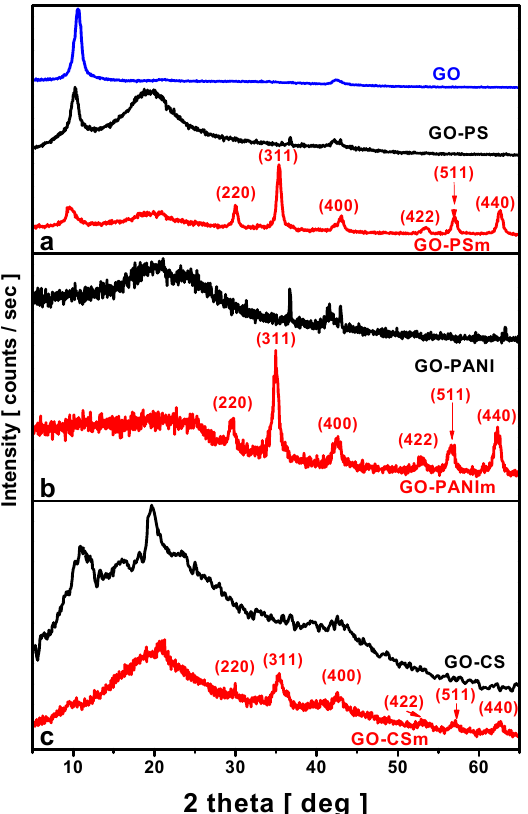
Figure 1. X-ray di ff raction pattern of composed materials from 5 ◦ to 65 ◦ . ( a ) GO-PS and GO-PSm; ( b ) GO-PANI and GO-PANIm; ( c ) GO-CS and Figure 1. X-ray diffraction pattern of composed materials from 5° to 65°. ( a )GO-PS and GO-PSm; ( b )GO-PANI and GO-PANIm; ( c )GO-CS and GO-CSm.